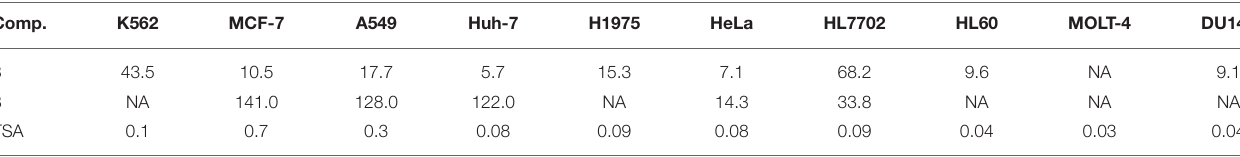
TABLE 3 | Cytotoxic results of the compounds (IC 50 , µ M).